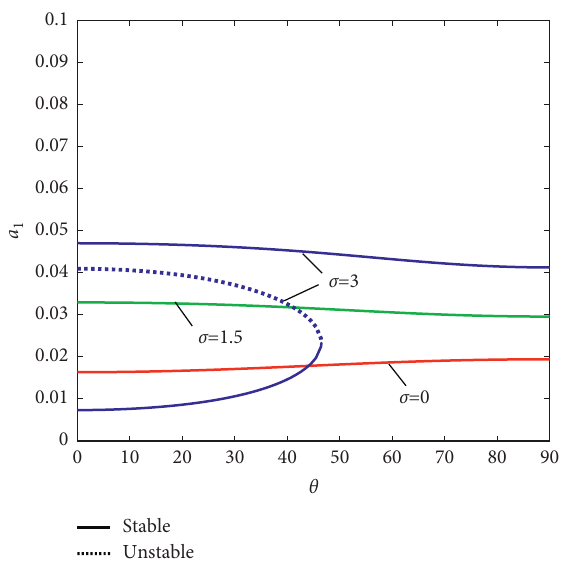
Figure 18: Amplitude versus ply angle with different damping coefficients (L/d � 10, σ � 2, case